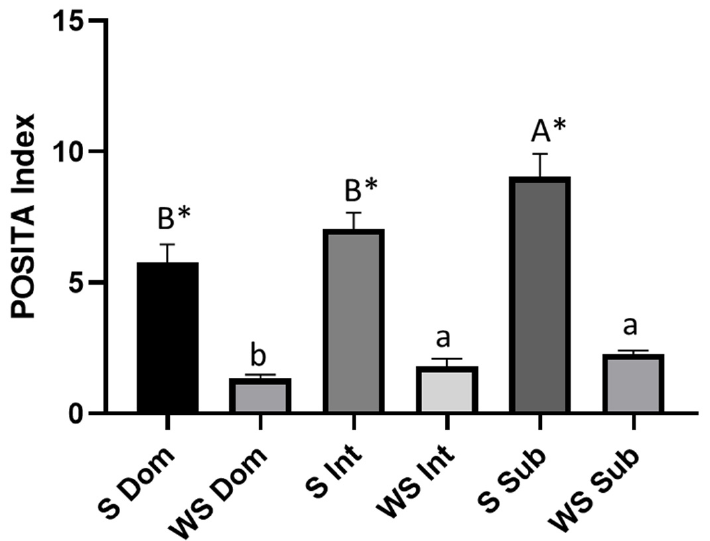
Figure 4. Positions after feeding (POSITA index) in Senegalese sole juveniles for dominant ( n = 6), intermediate ( n = 12) and subordinate fish ( n = 6) per environment. S = Sand; WS = Without Sand; Dom = dominant; Int = Intermediate; Sub = Subordinate. Data are shown as mean ± SD. Different letters indicate significant differences within the same environment; (*) denotes significant differences between treatments within the same social category (Two-Way ANOVA; p < 0.05).